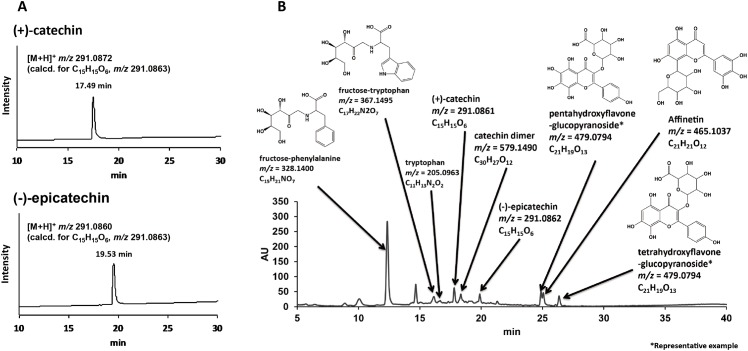
LC-ESI-MS analyses of standard reagents (A) and representative LC chromatogram with estimated chemical structural formulas obtained from MeOH soluble fraction of GPE (B).